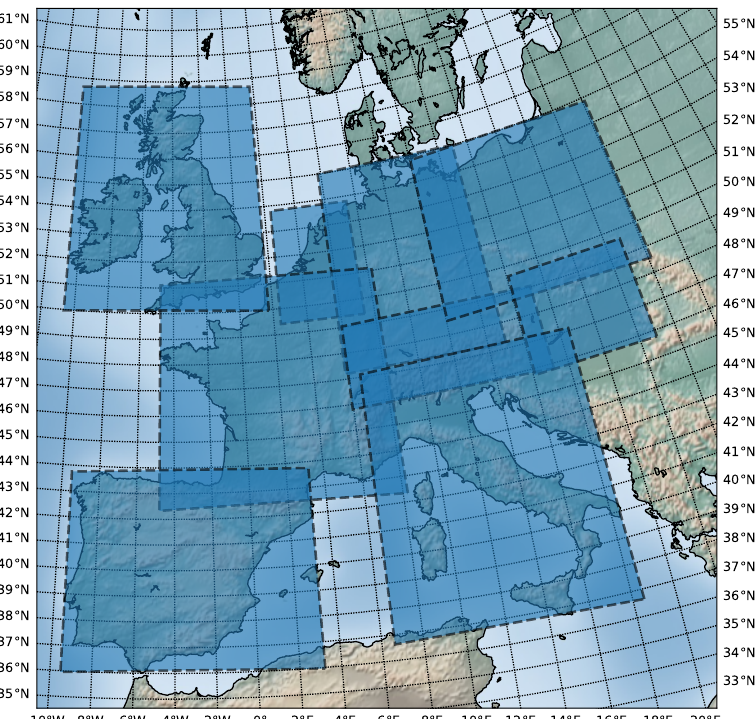
Figure 1. Spatial extents used for nowcasting covering a total area of approximately 10.46 million km 2 , including the United Kingdom and Ireland (UK), Spain and Portugal (ES), France including Andorra and Monaco (FR), Switzerland and Austria (AT), Belgium, The Netherlands and Luxembourg (NL), Italy (IT), Germany (DE), Poland and the Czech Republic (PL), Hungary and Slovakia